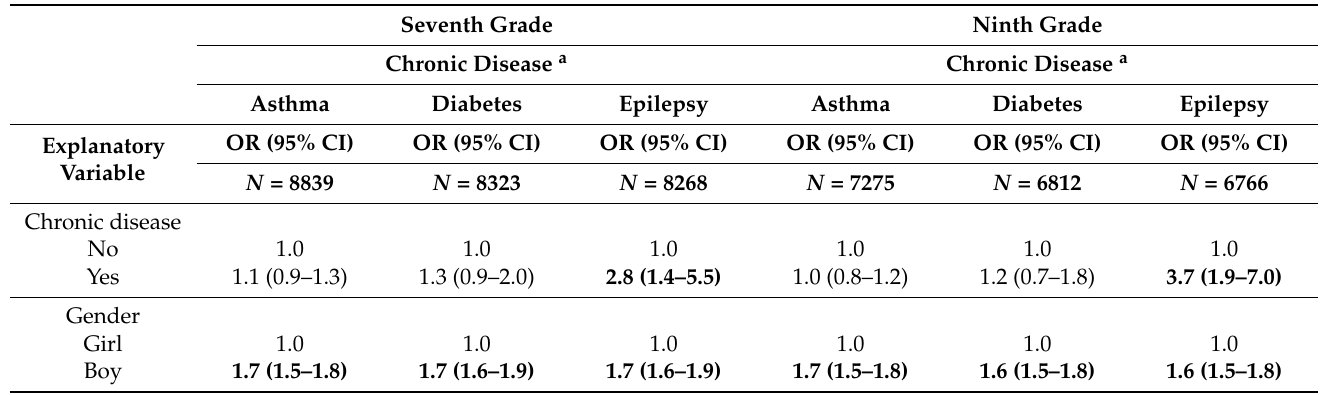
Table A2. The associations between individual chronic diseases and ending up at a non-academic upper-secondary school in the seventh and ninth grade. Bivariate logistic regression model. Odds ratios (OR) and their 95% confidence intervals (95%